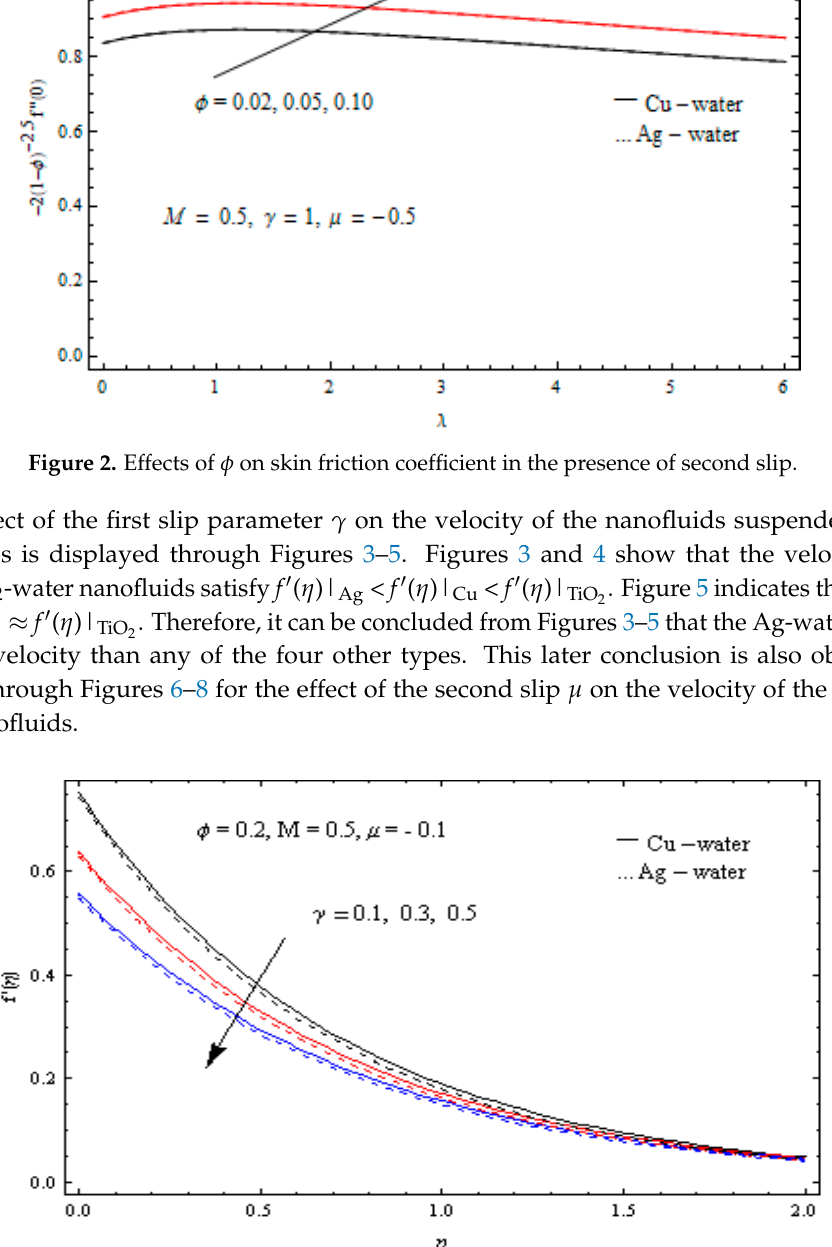
γ Figure 3. Effect of first slip on velocity of Cu-water and Ag-water nanofluids. Figure 3. Effect of first slip γ on velocity of Cu-water and Ag-water